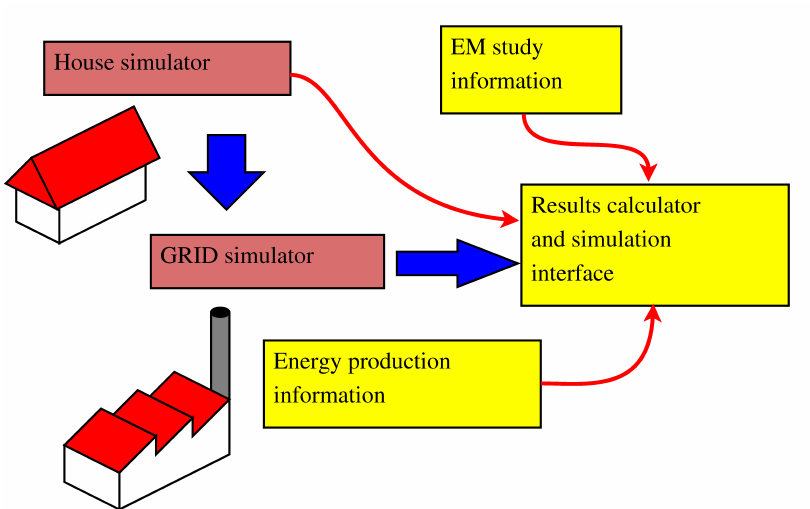
Figure 8. Energy management study